Question: Briefly state, in one sentence, what is plotted here.
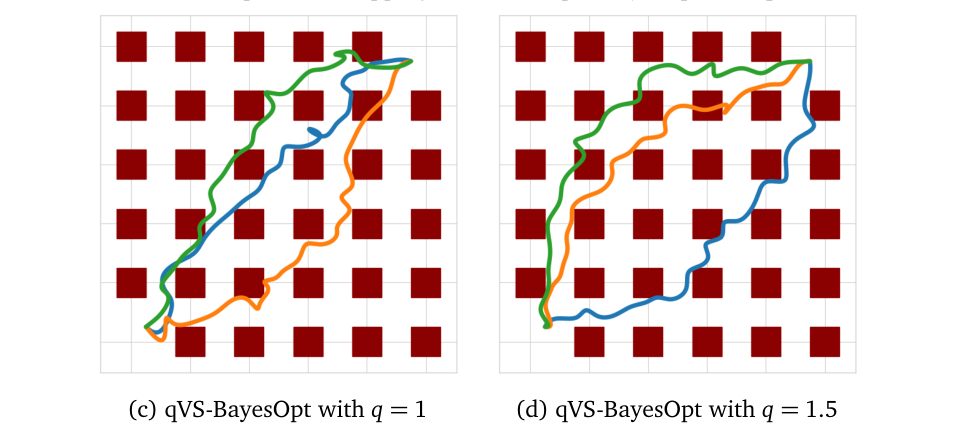
Answer: Trajectories identified by various search methods in the rover path finding problem. Our method finds a diverse set of paths, whose diversity can be controlled using the order q of the qVS.